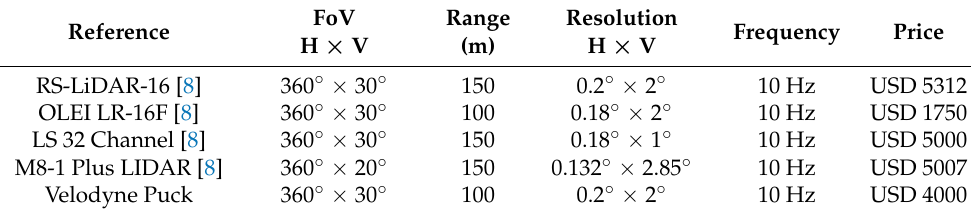
Table 3. Relevant characteristics of mechanical 3D LiDARs used for robot perception.